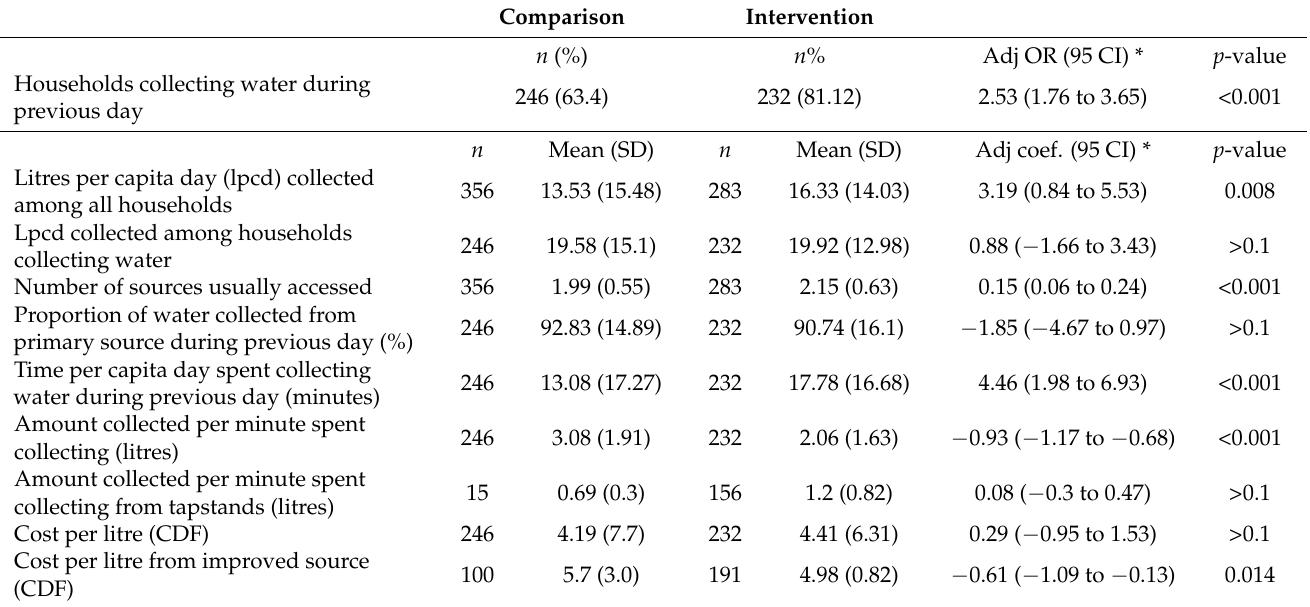
Table 3. Water collection outcomes in